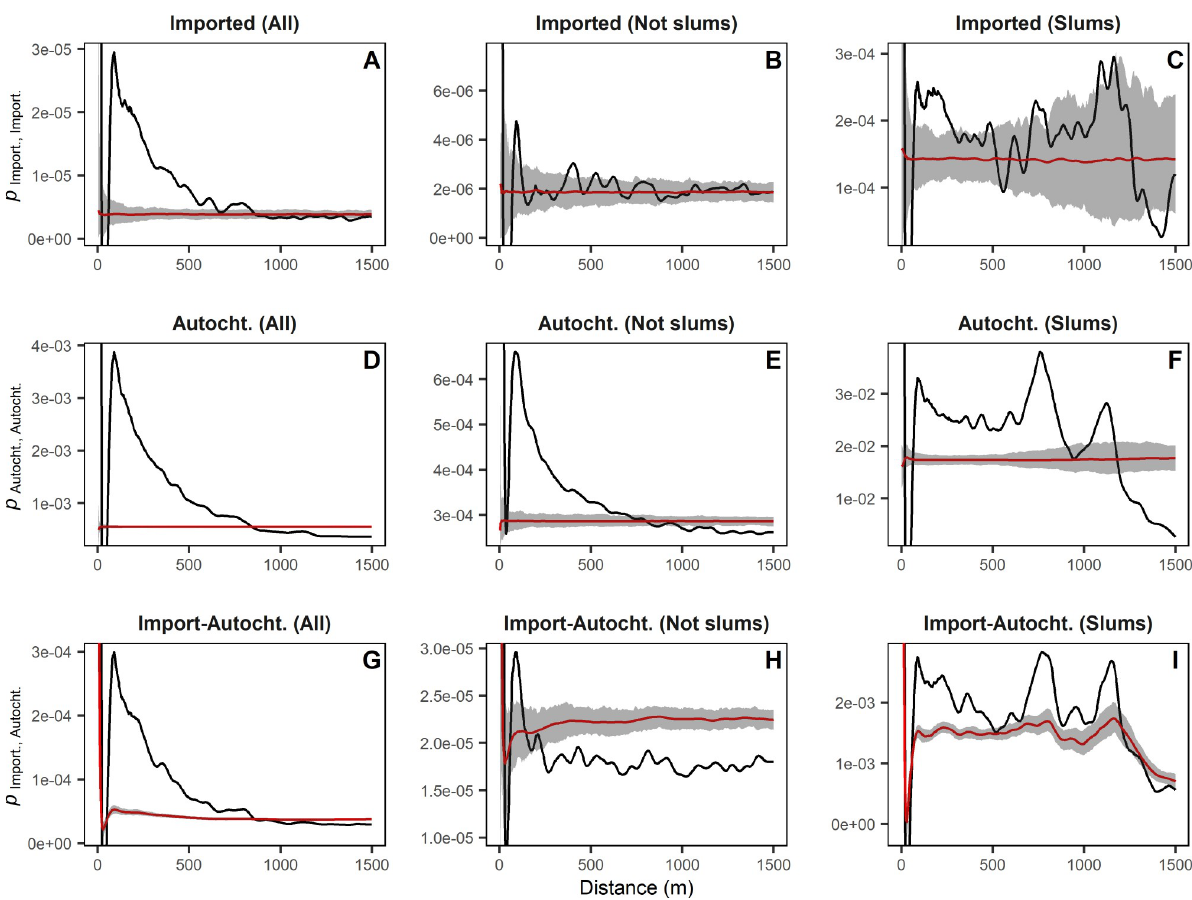
Fig 4. Imported dengue cases clustered only in slums, whereas autochthonous cases clustered citywide. The mark-connection function, p , assessed the spatial distribution between the groups of selected cases in Buenos Aires. A, B and C) Imported cases. D, E and F) Autochthonous cases. G, H and I) Autochthonous cases according to imported cases. A, D and G) Cases in all the city. B, E and H) Only cases outside slums. C, F and I) Only cases in slums. The black line shows the values for the observed pattern. The red line shows the mean value for the random patterns. The shading represents the 95% confidence interval for the random patterns. Random patterns were generated by random labeling among the inhabitants of the city. Observed values above 95% confidence interval denote clustered distribution.